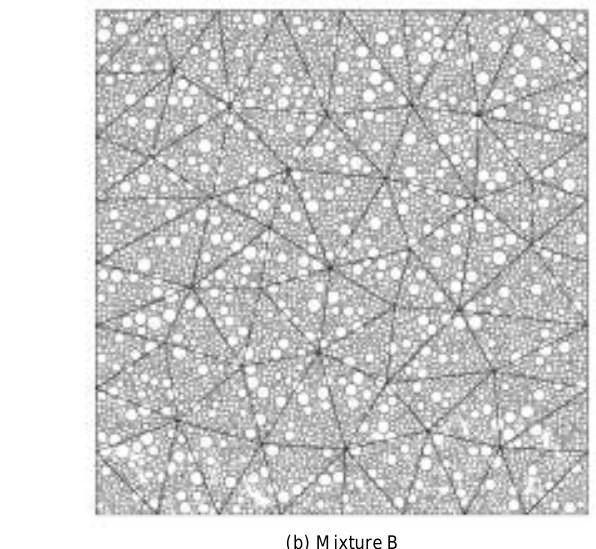
Mixture A Fig. 3 The closely packed structure of polydispersed granular material of (a) mixture A; (b) mixture